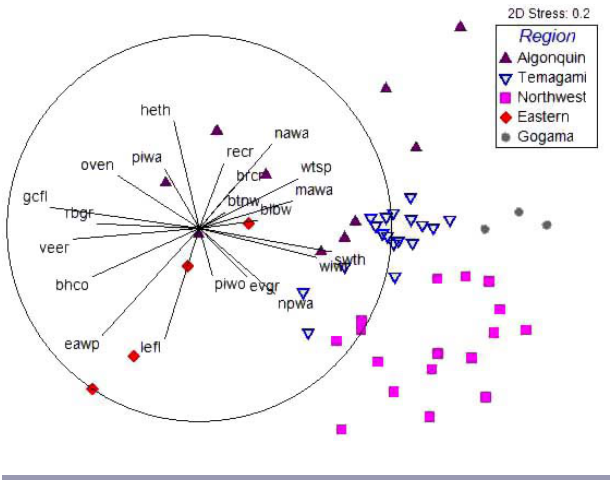
Fig. 3 . Nonmetric multidimensional scaling plot of pine stands showing regions. Species with Pearson correlations of >0.45 with axes: bhco (Brown-headed Cowbird); eawp (Eastern Wood-pewee); gcfl (Great-crested Flycatcher); heth (Hermit Thrush); lefl (Least Flycatcher); mawa (Magnolia Warbler); mowa (Mourning Warbler); nawa (Nashville Warbler); npwa (Northern Parula Warbler); oven (Ovenbird); rbgr (Rose-breasted Grosbeak); rbnu (Red- breasted Nuthatch); swth (Swainson's Thrush); veer (Veery); wiwr (Winter Wren); wtsp (White-throated Sparrow). Focal species: blbw (Blackburnian Warbler); brcr (Brown Creeper); btnw (Black-throated Green Warbler); evgr (Evening Grosbeak); piwa (Pine Warbler); piwo (Pileated Woodpecker); recr (Red Crossbill).